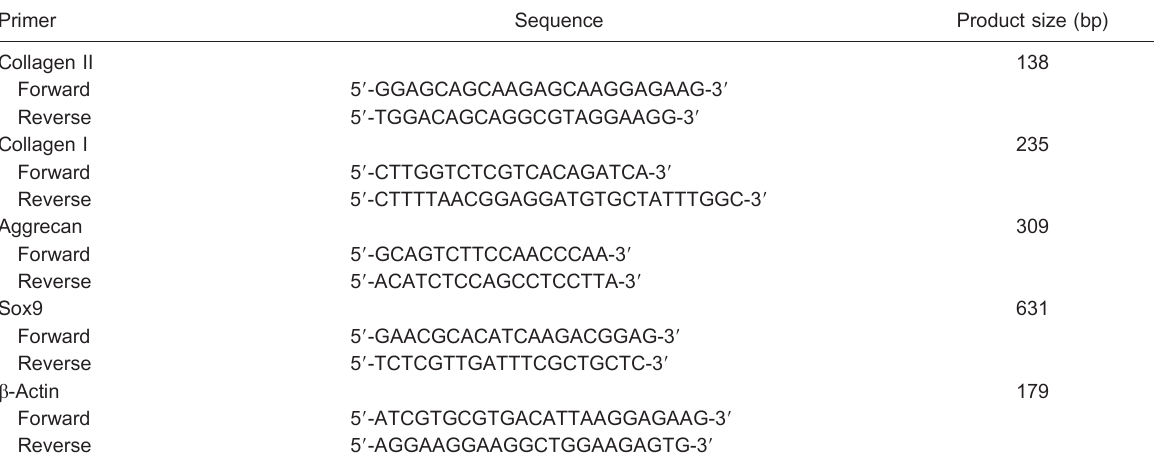
Table 1. Primers used for